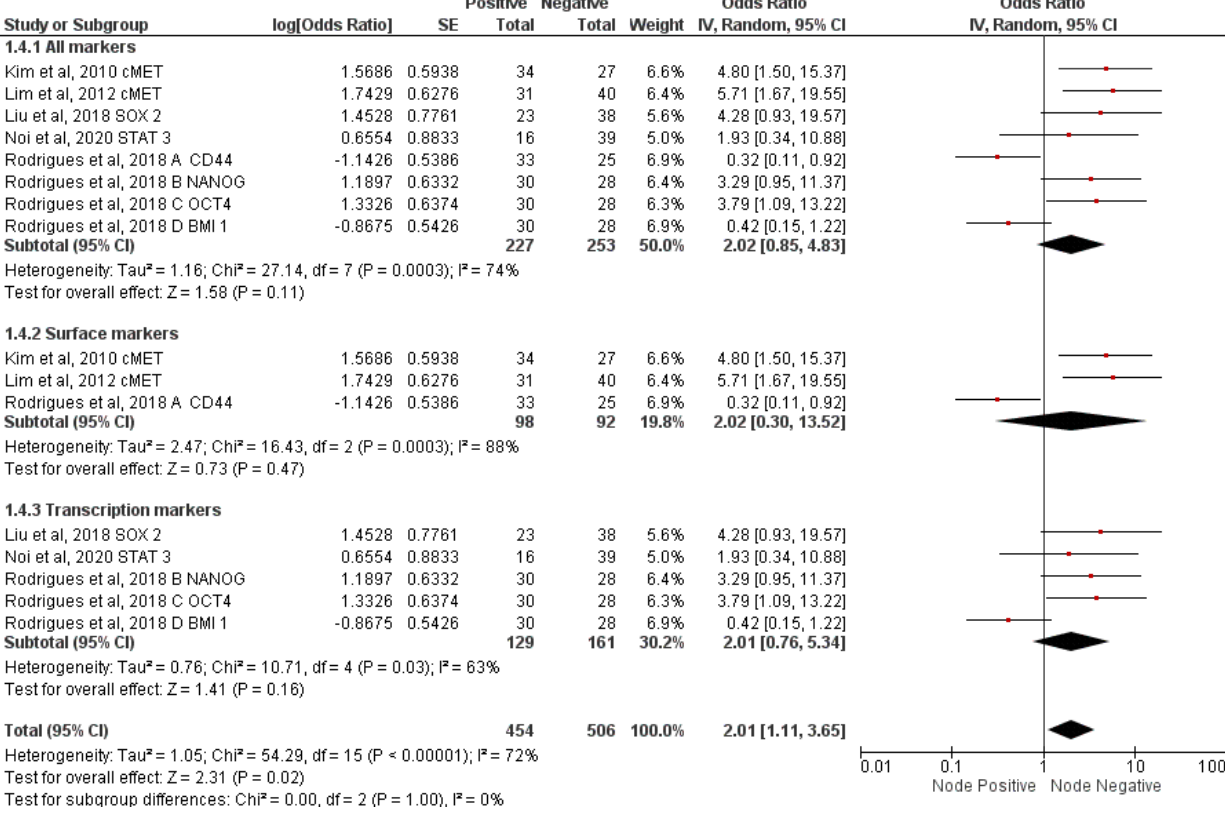
Figure 4. Meta−analysis of CSC markers and nodal metastasis [29,30,32–34].